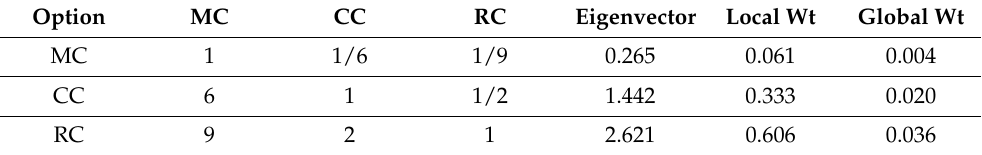
Table A7. Comparison of alternatives matrix for subcriterion SA3.